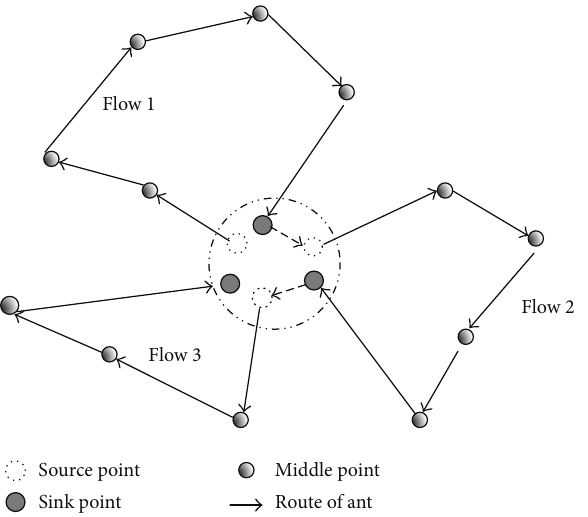
Figure 1: Improvement process of solution